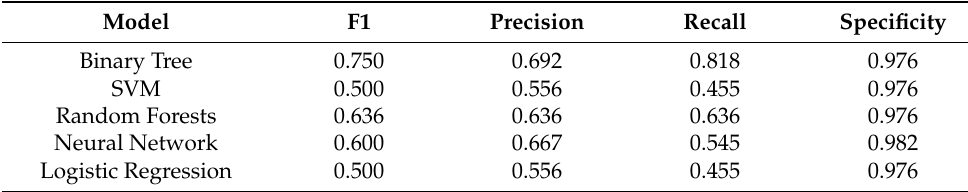
Table 13. Models accuracy metrics for add to cart action (class 1) with add_to_cart_direct as target parameter.